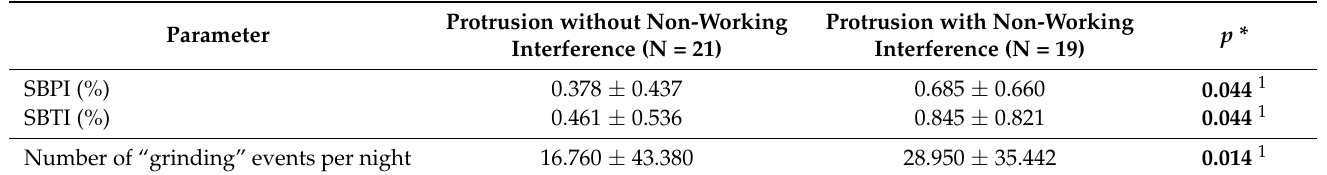
Table 6. Association between bruxism indices and the presence of non-working interferences.